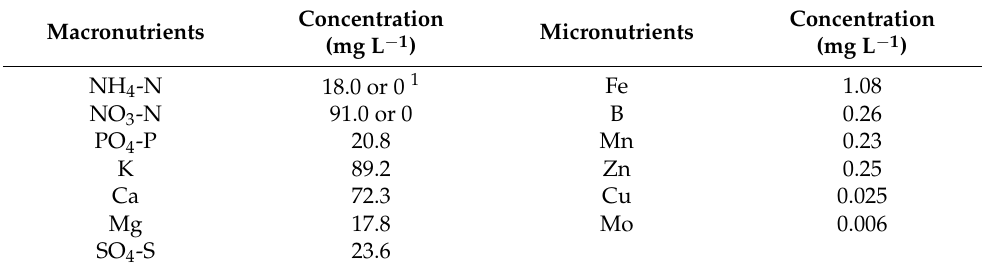
Table 1. Chemical compositions of nutrient solutions used in experiments.